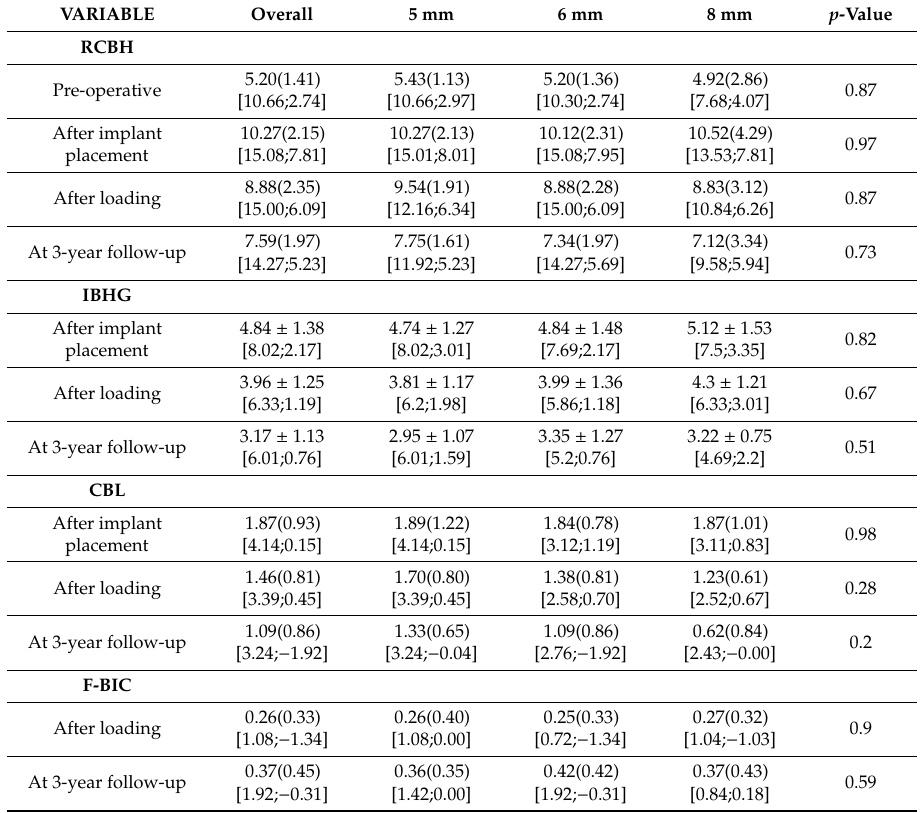
Table 4. Comparison of RCBH, IBHG, CBL, and F-BIC at each time interval, between length groups. Values are presented as mean ± SD (max;min) or median(iqr)